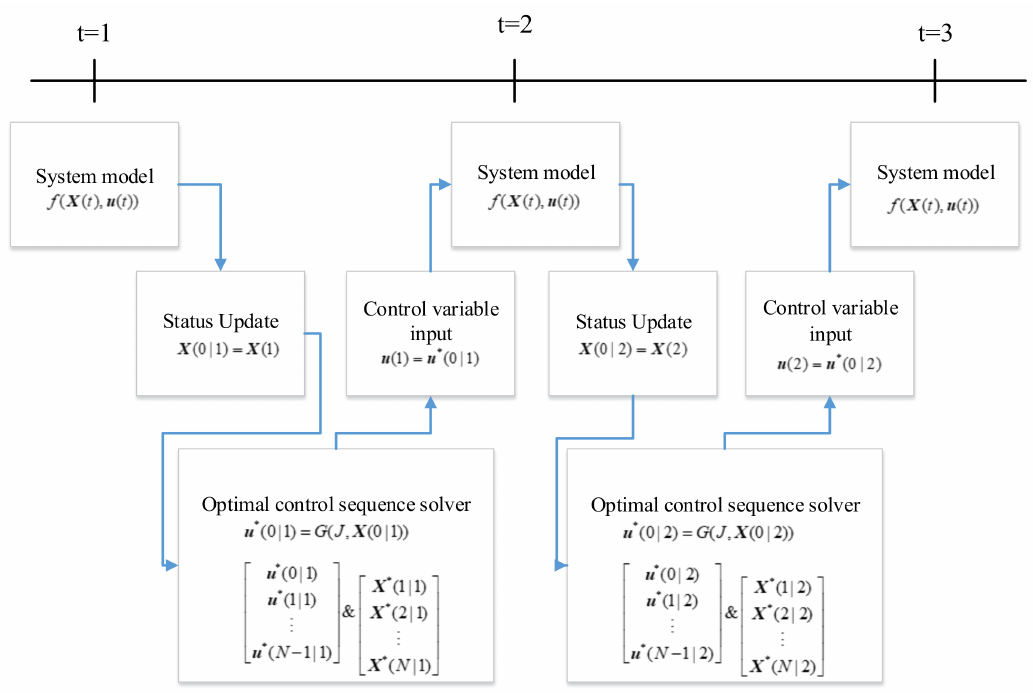
Figure 3. Schematic diagram of the MPC framework